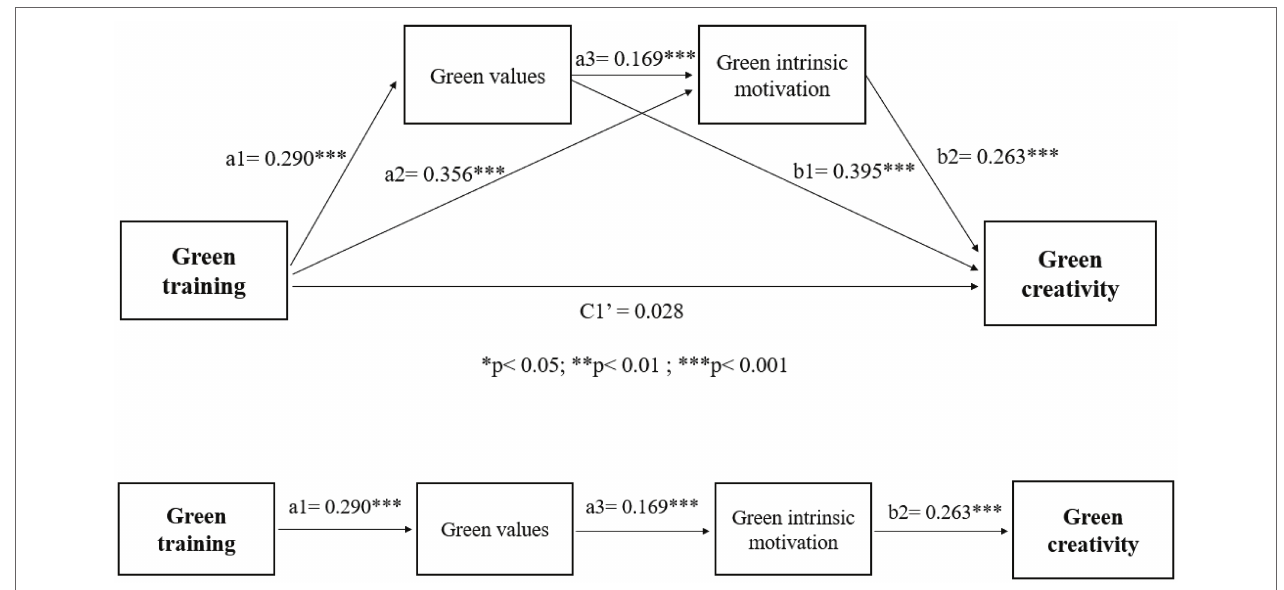
FIGURE 2 | The results of the sequential model with path